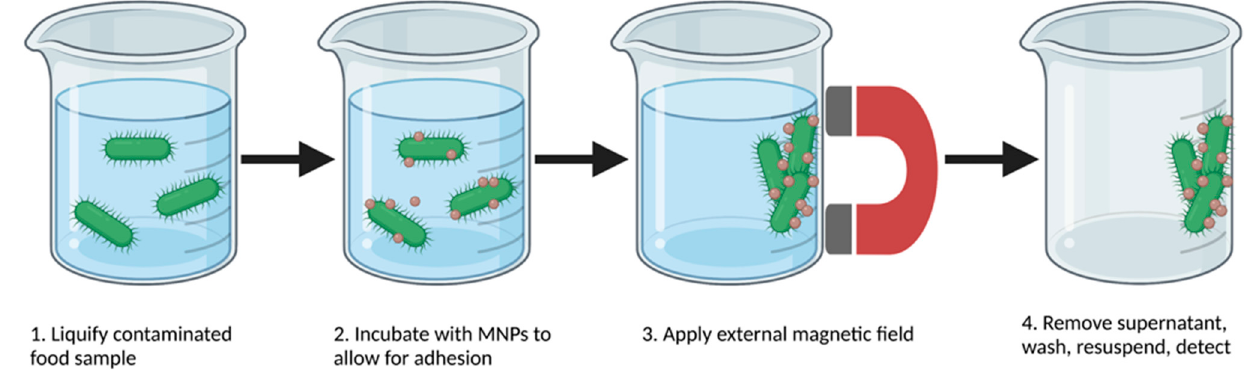
Figure 2. Overview of magnetic separation of bacteria from food samples.